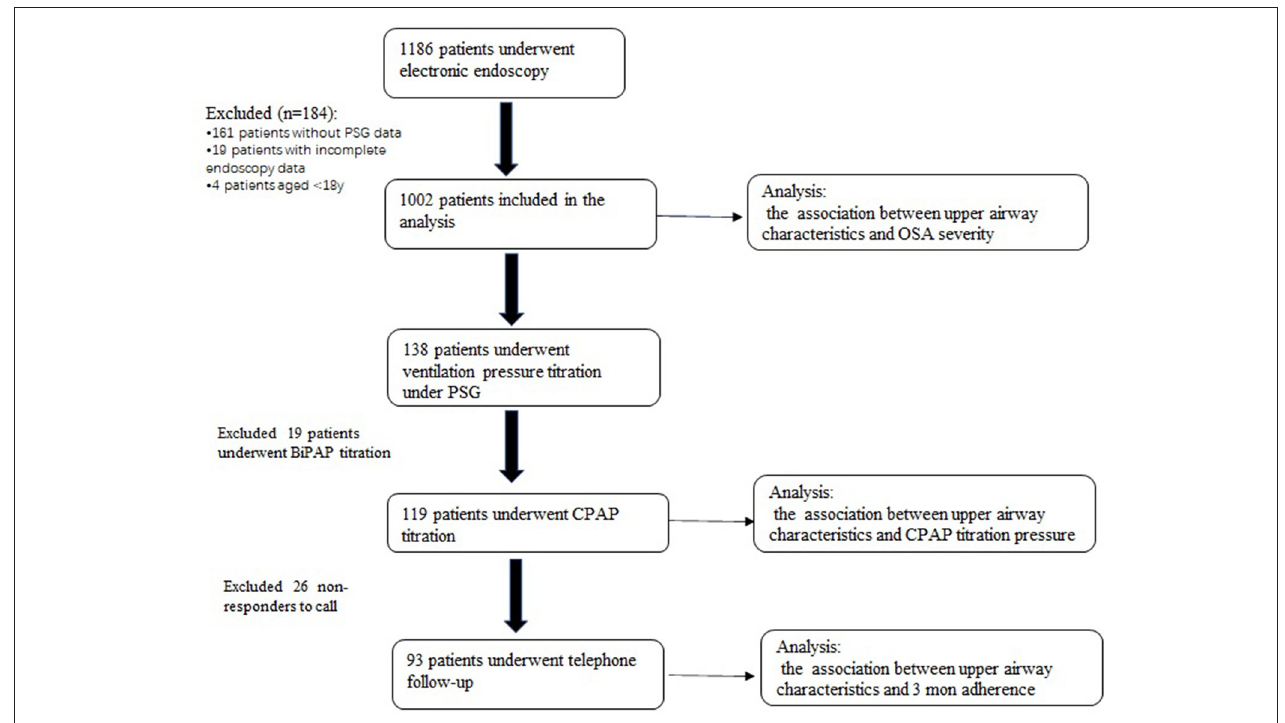
FIGURE 1 | Patient enrollment flow